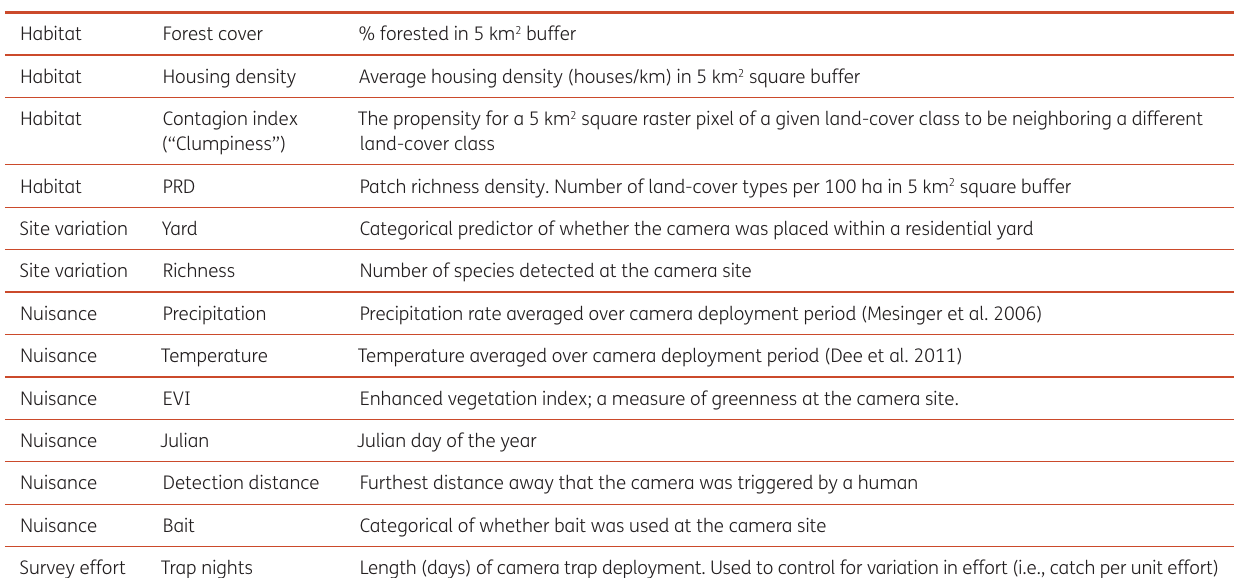
Table 2 Covariates used in occupancy